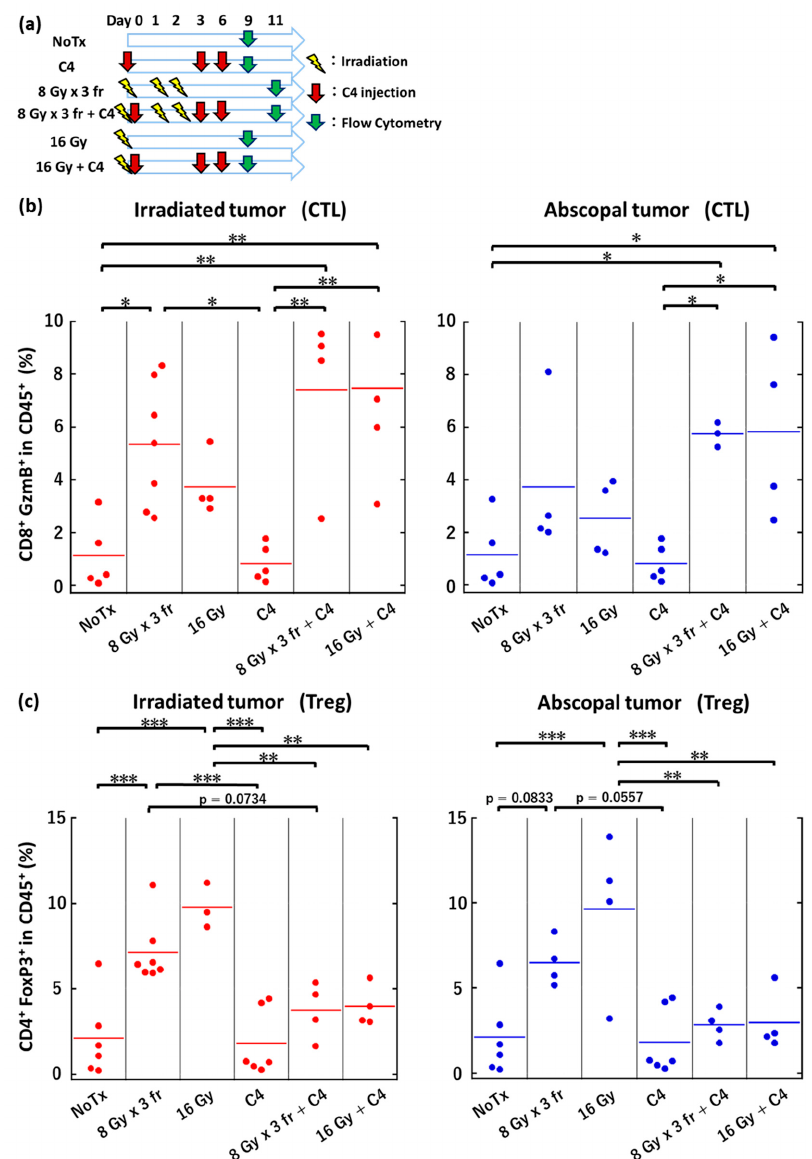
Figure 6. The immune microenvironment changes in tumors by combination therapy of radiation and C4. ( a ) The treatment schedule. ( b ) Dot plots showing the proportion of CTL on day 9 in the irradiated tumors in NoTx (N = 5), C4 (N = 5), 8 Gy × 3 fr (N = 7), 8 Gy × 3 fr + C4 (N = 4), 16 Gy (N = 4), and 16 Gy + C4 (N = 5) groups and in the abscopal tumors in NoTx (N = 5), C4 (N = 5), 8 Gy × 3 fr (N = 4), 8 Gy × 3 fr + C4 (N = 3), 16 Gy (N = 4), and 16 Gy + C4 (N = 4) groups. ( c ) Dot plots showing the proportion of Treg on day 9 in the irradiated tumors in NoTx (N = 6), C4 (N = 6), 8 Gy × 3 fr (N = 7), 8 Gy × 3 fr + C4 (N = 4), 16 Gy (N = 3), and 16 Gy + C4 (N = 4) groups and in the abscopal tumors in NoTx (N = 6), C4 (N = 6), 8 Gy × 3 fr (N = 4), 8 Gy × 3 fr + C4 (N = 4), 16 Gy (N = 4), and 16 Gy + C4 (N = 4) groups. Representative flow cytometry dot plots of CTL and Tregs are provided in Figure S2a,b, respectively. Tukey–Kramer’s HSD test was used to compare CTL and Treg between multiple groups. ***: p < 0.001, **: p < 0.01, *: p < 0.05. NoTx: no treatment; C4: anti-CTLA-4 antibody; CTL: cytotoxic T lymphocytes; Treg: regulatory T cell; fr: